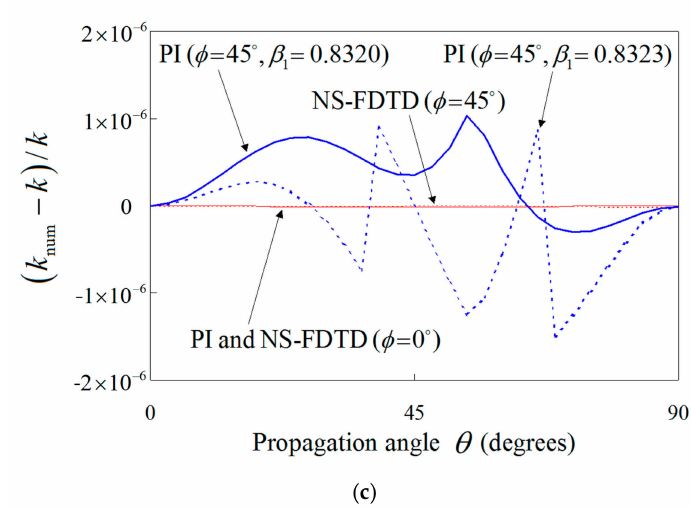
Figure 7. Propagation error of the numerical wavenumber, k num , obtained via the Newton-Raphson method using Equation (25), for the NS-FDTD method combined with the proposed PI model and ( a ) ∆ = λ /12, ( b ) ∆ = λ /16, and ( c ) ∆ = λ /20. Note that ∆ is the grid size, k the physical wavenumber, λ the wavelength, and φ , θ the angles of the spherical coordinate system ( r , φ , θ ) . For comparison, the typical NS-FDTD results [6] are also included.